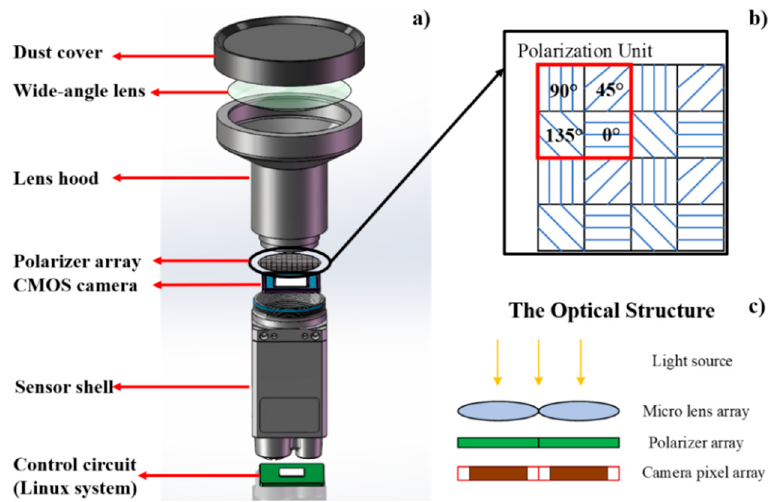
Figure1. Bionicpolarized-sensorstructurediagram. ( a Figure 1. Bionic polarized-sensor structure diagram. ( a ) Bionic polarization sensor hardware component; ( b ) one example of the polarization unit with different installation angle; ( c ) the optical structure of the sensor.